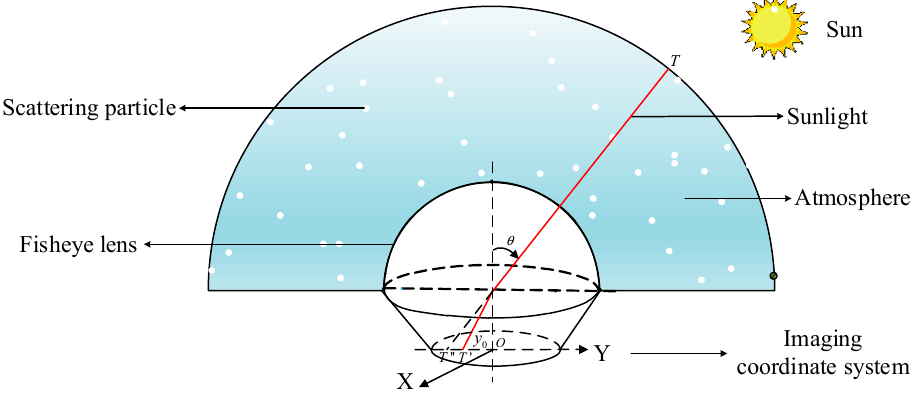
Figure 4. Schematic diagram of sunlight entering a polarization imaging system consisting of a fisheye lens and a CCD after scattering of particles in the atmosphere. T stands for any point in the celestial sphere, T (cid:48) stands for the point projected onto the two-dimensional plane according to the equidistance imaging mode of the fisheye lens, T (cid:48)(cid:48) stands for the point of the ordinary lens, θ stands for the zenith angle of any point T of the celestial sphere, y 0 represents the distance from the point after equidistant imaging to the center of the imaging plane.